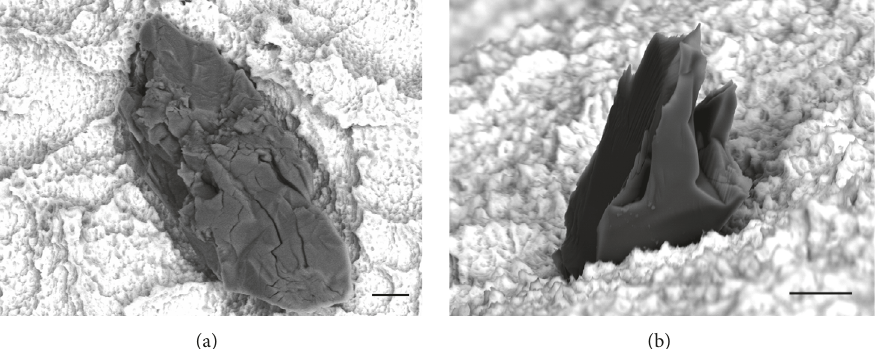
Figure 6: High magnification images of Al 2 O 3 particles. Scale bar: 10 𝜇 m. Note the cracked morphology of the particle on the surface of BL Roxolid (cid:2) SLActive (cid:2) implant in (a) and a particle protruding out from the surface of BLX Roxolid (cid:2) SLActive (cid:2) implant (b). Scale bars: 10 𝜇